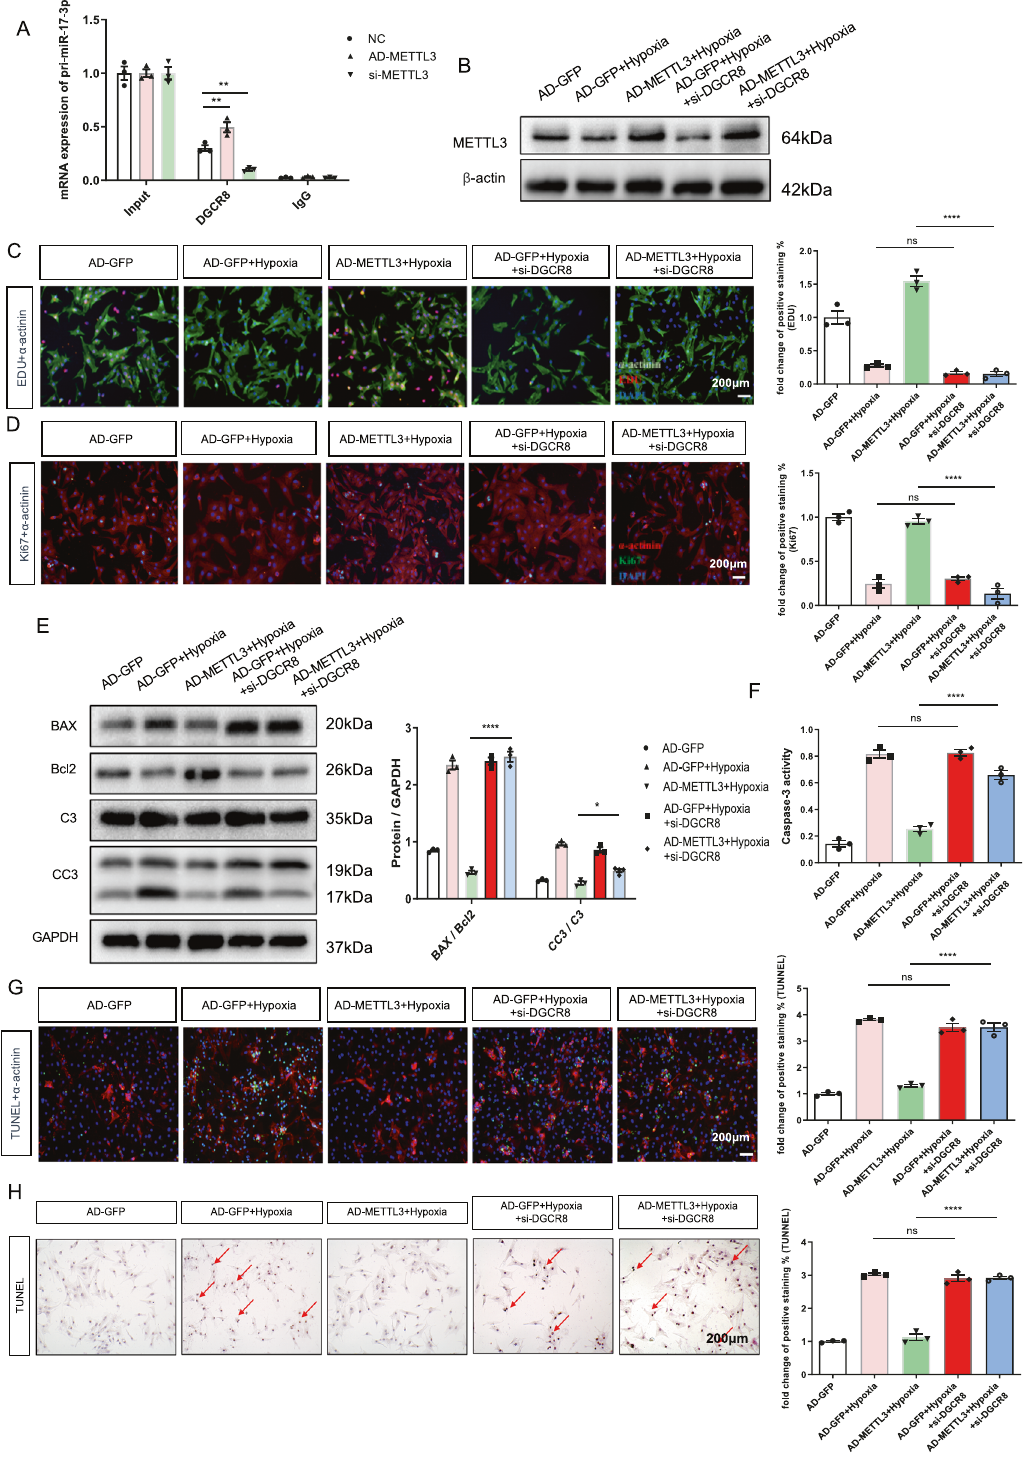
Fig. 7 si-DGCR8 pretreatment impeded the positive effects of METTL3 in hypoxia-induced NRCMs. A mRNA expression of pri-miR-17-3p is determined by RNA Immunoprecipitation. B Protein expression of METTL3 in the NRCMs from indicated groups. C Representative immuno fl uorescence images of NRCMs labeled with EDU or α -actinin (EDU, red; α -actinin, green; DAPI, blue. Scale bars, 200 μ m). D Representative immuno fl uorescence images of NRCMs labeled with Ki67 or α -actinin ( α -actinin, red; Ki67, green; DAPI, blue. Scale bars, 200 μ m). E Protein expression of BAX, Bcl2, C3, and CC3 in the NRCMs from indicated groups. F Caspase 3 activities of NRCMs from indicated groups. G , H Representative immuno fl uorescence ( G ) and immunohistochemical ( H ) staining images of NRCMs labeled with TUNEL ( α -actinin, red; TUNEL, green; DAPI, blue. Scale bars, 200 μ m), and the corresponding quantitative analysis. N = 3. The results are expressed as the mean ±